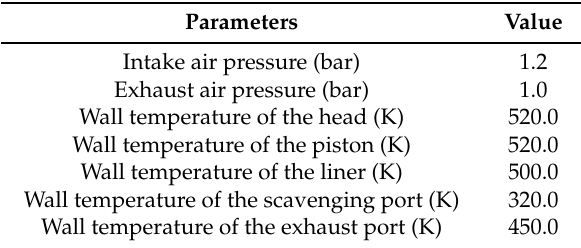
Table 3. The initial boundary conditions of the CFD scavenging model.